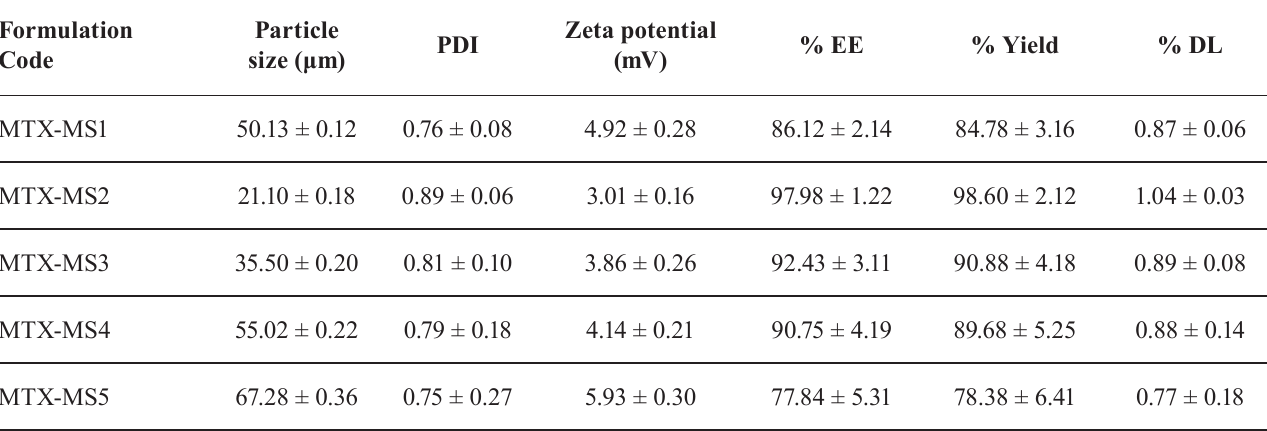
TABLE II – Characterization of MTX loaded different mucoadhesive microparticles